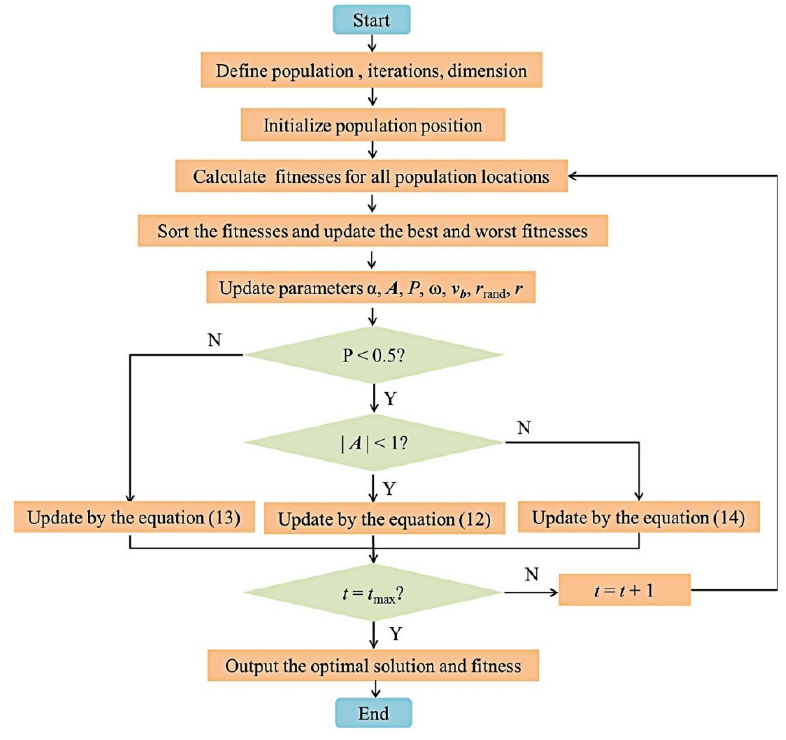
Figure 1. Flow chart of the SMWOA.